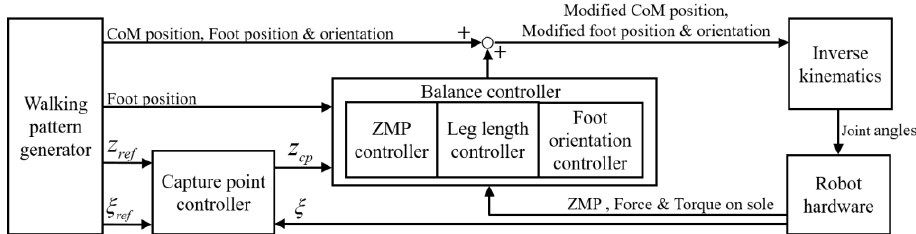
Figure 1. Overview of the information flow in proposed balance control framework.